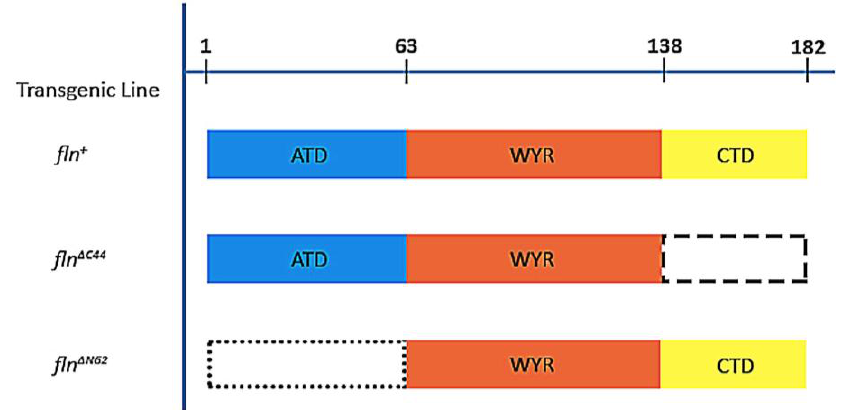
Figure 1. Representation of the three domains of flightin (fln) and their expression in three experimental strains. Top line numbers indicate amino acid position. The fln Δ C44 strain lacks the carboxy terminal domain (CTD) and fln Δ N62 lacks the amino terminal domain (ATD) of the protein. The fln + strain acts as a control transgenic line as it expresses a reintroduced full length flightin.